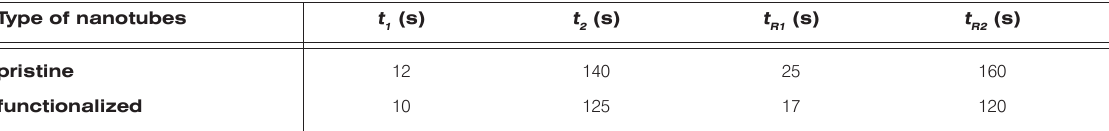
sensing at room 2